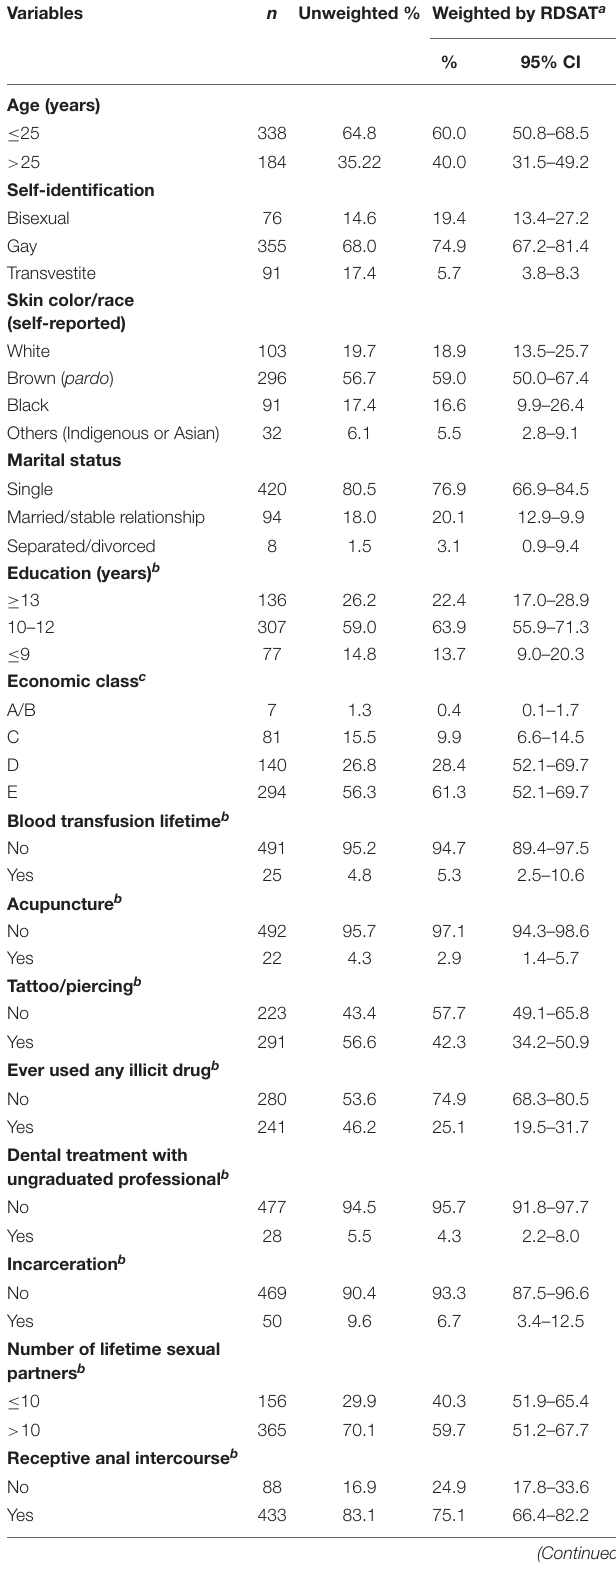
TABLE 1 | Characteristics of the studied MSM from Goiânia, Central-Western Brazil.